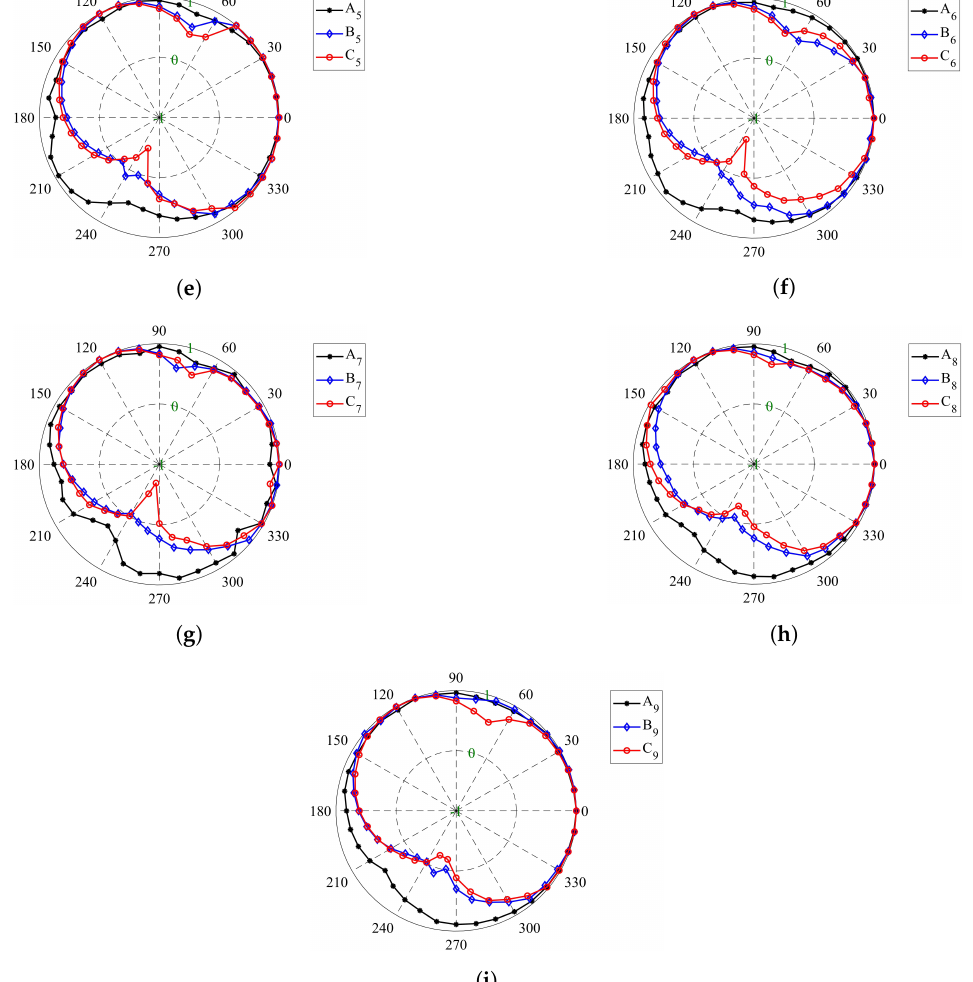
Figure 8. Circular diagrams of the normalized second-order work of ( a ) specimen S 1 , ( b ) specimen S 2 , ( c ) specimen S 3 , ( d ) specimen S 4 , ( e ) specimen S 5 , ( f ) specimen S 6 , ( g ) specimen S 7 , ( h ) specimen S 8 , ( i ) specimen S 9